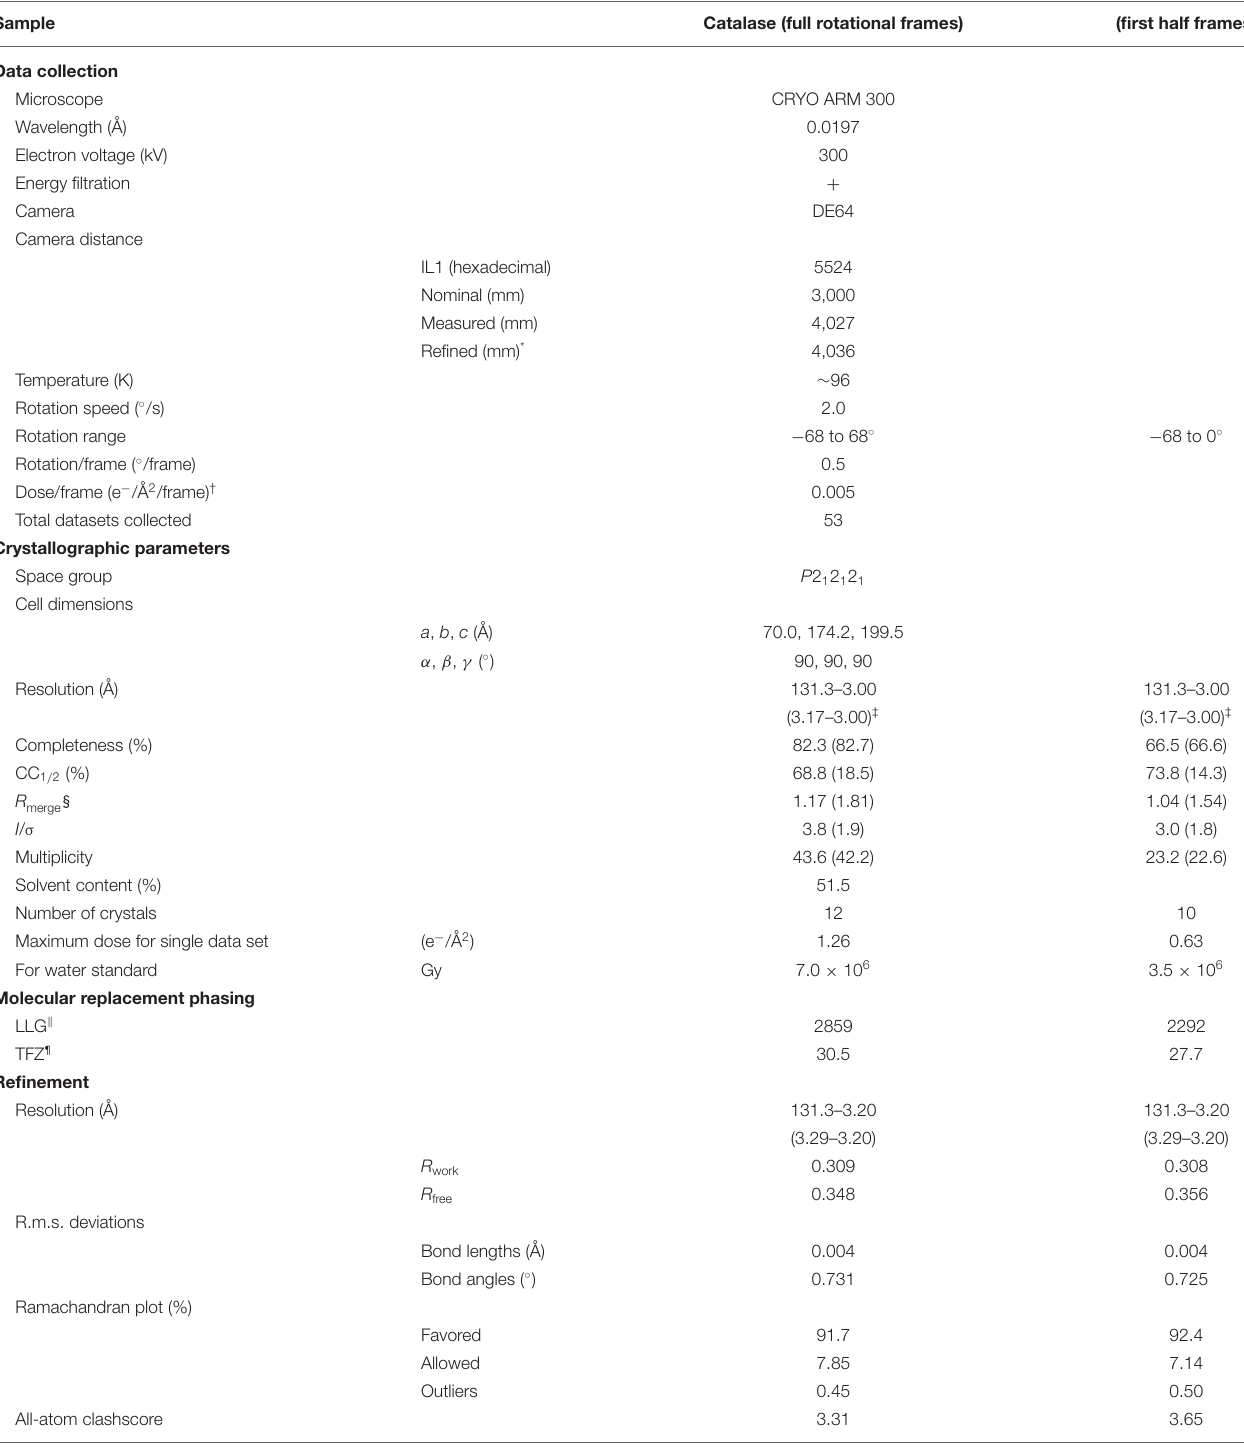
TABLE 1 | Data collection, crystallographic, and refinement statistics of